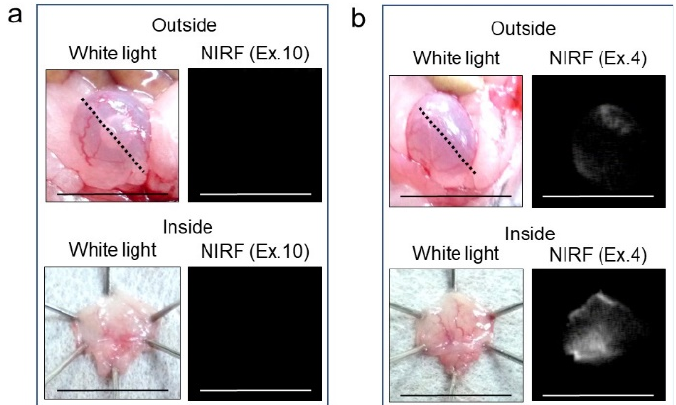
Figure 3. Near-infrared fluorescence (NIRF) imaging of six normal bladders. The 2.4- μ M ( a ) or 24- μ M ( b ) ASP5354 was injected in normal bladder, 5 min after which, the bladder was rinsed with saline 5 times, filled up with saline, and NIRF imaging was performed from outside the bladder. After imaging, the bladder was picked out and opened along the black dotted line. NIRF in the obtained bladder inner layer was imaged. Excitation levels (Ex.) are shown above the photos. NIRF is displayed in white. Scale bar represents 10 mm.